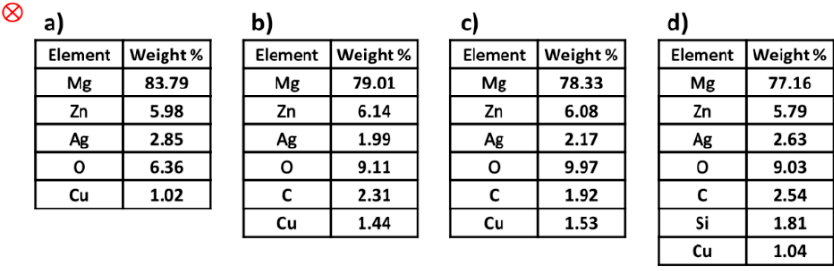
Figure 8. The extracted values of EDAX analysis: ( a ) alloy, ( b ) C1, ( c ) C2 and ( d ) C3.